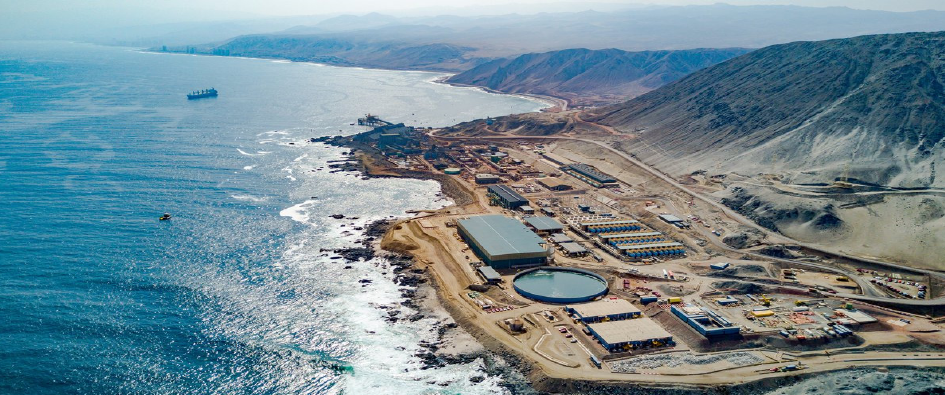
Figure 15. Escondida Mine Sea Water Desalination Plant, Chile [44]. Table 5. Sea water use at mine operations for metallurgical and tailings process.